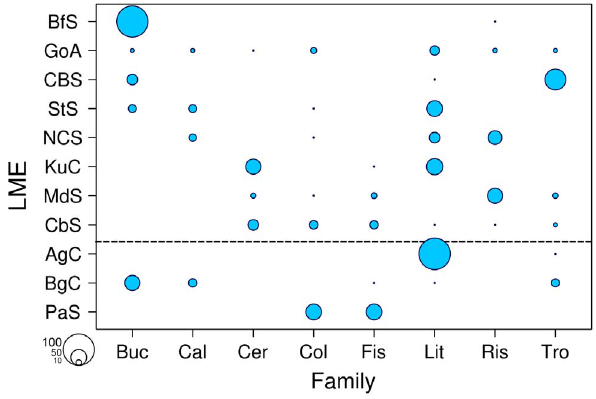
Figure 5. Relative contribution of the number of species (UGE standardized for n=10) within the eight cosmopolitan families among the LMEs. Buc: Buccinidae, Cal: Calyptraeidae, Cer: Cerithiidae, Col: Columbellidae, Fis: Fissurellidae, Lit: Littorinidae, Tro: Trochidae, Ris: Rissoidae. LME abbreviations as in figure 1. Horizontal line separates northern from southern